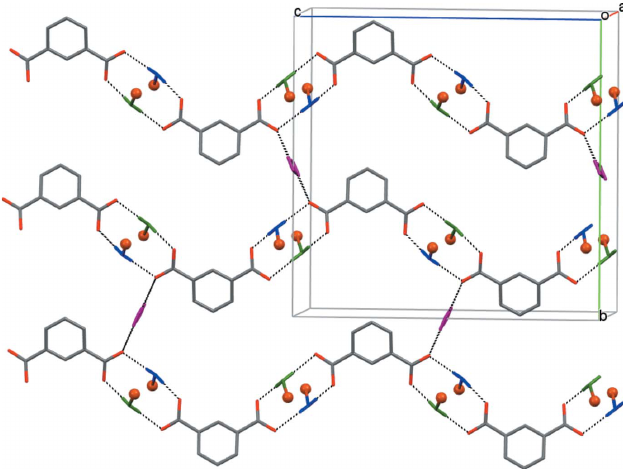
Figure 6 Sheets of isophthalate dianions parallel to the (100) plane in (II). Macrocyclic ligands and H atoms at carbon atoms of the carboxylate anions are omitted, only water molecules coordinated to Cu II (balls) participating in the formation of a carboxylate layer are shown (O1 W – green, O2 W – dark blue, O3 W – violet). Hydrogen bonds are shown as dashed